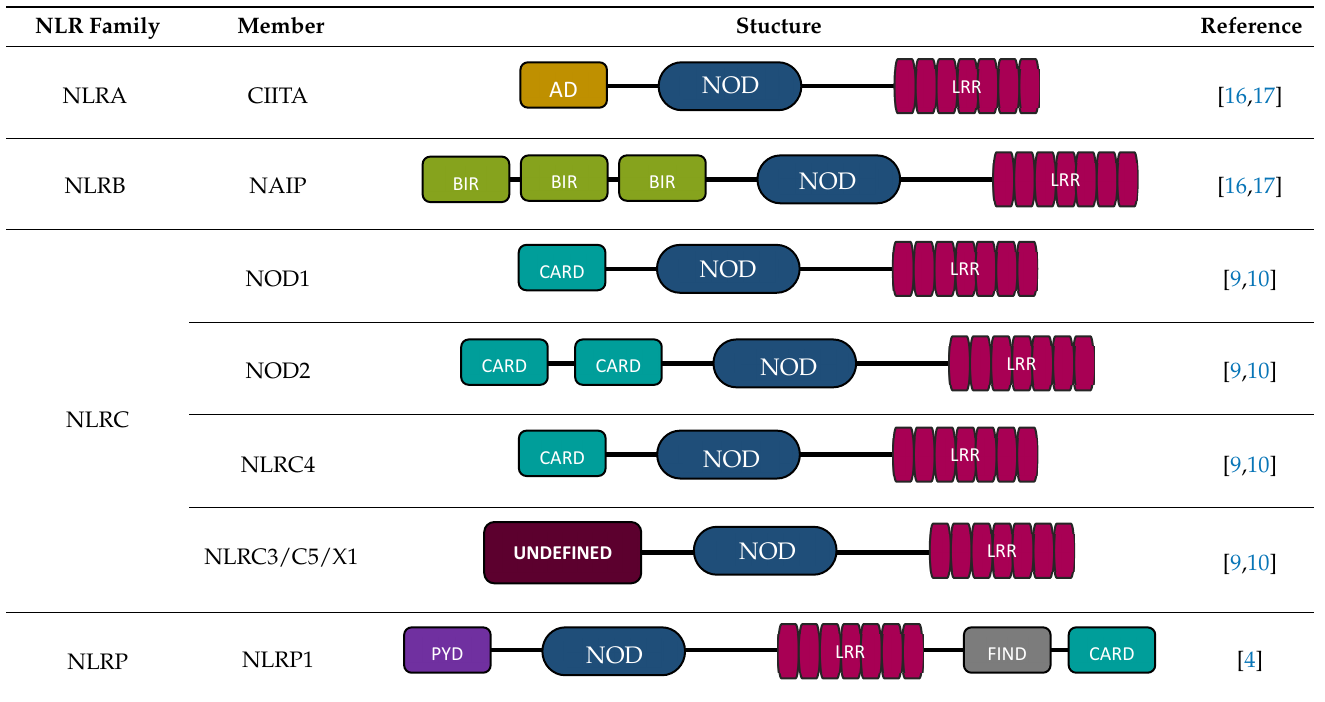
Table 1. Structures of the NLR subfamilies.